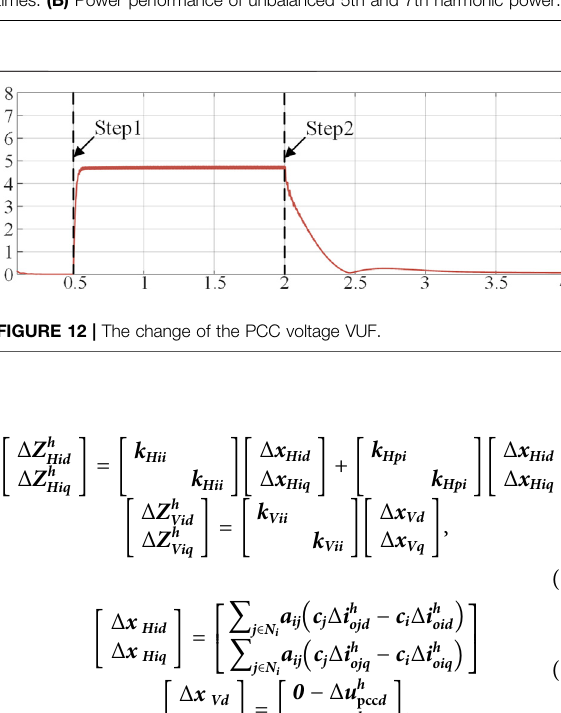
FIGURE 11 | Simulation results of voltage suppression and power sharing control. (A) Harmonic and unbalanced voltage at PCC and THD of voltage at different times. (B) Power performance of unbalanced 5th and 7th harmonic power.